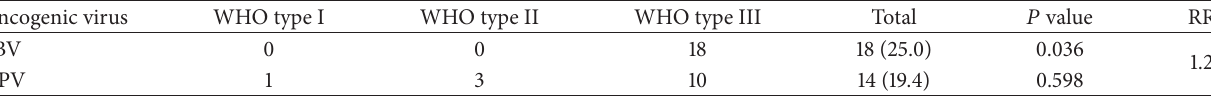
Table 3: Association of NPC histological subtypes and EBV/HPV presence 𝑛 = 72 .